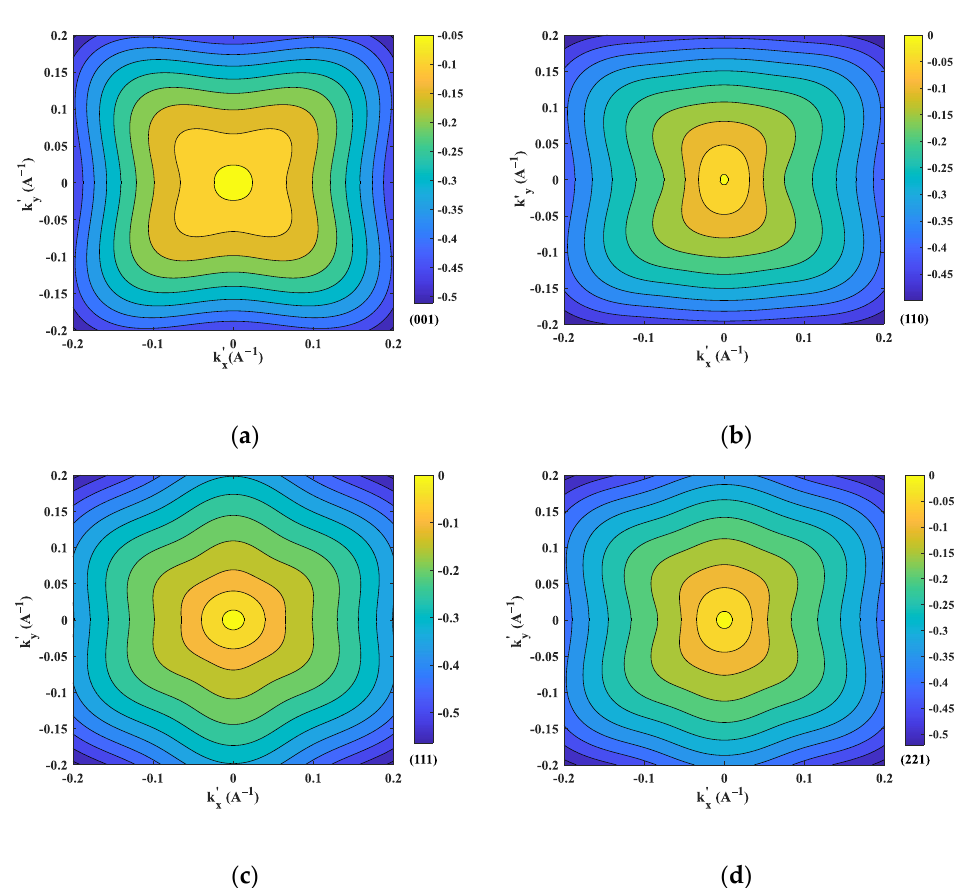
Figure 2. Equal-energy contour plots of the first valence band (HH1) in strain InGaAs QW with ( a ) (001), ( b ) (110), ( c ) (111), and ( d ) (221) orientations. The unit of the energy level in the legend is eV.